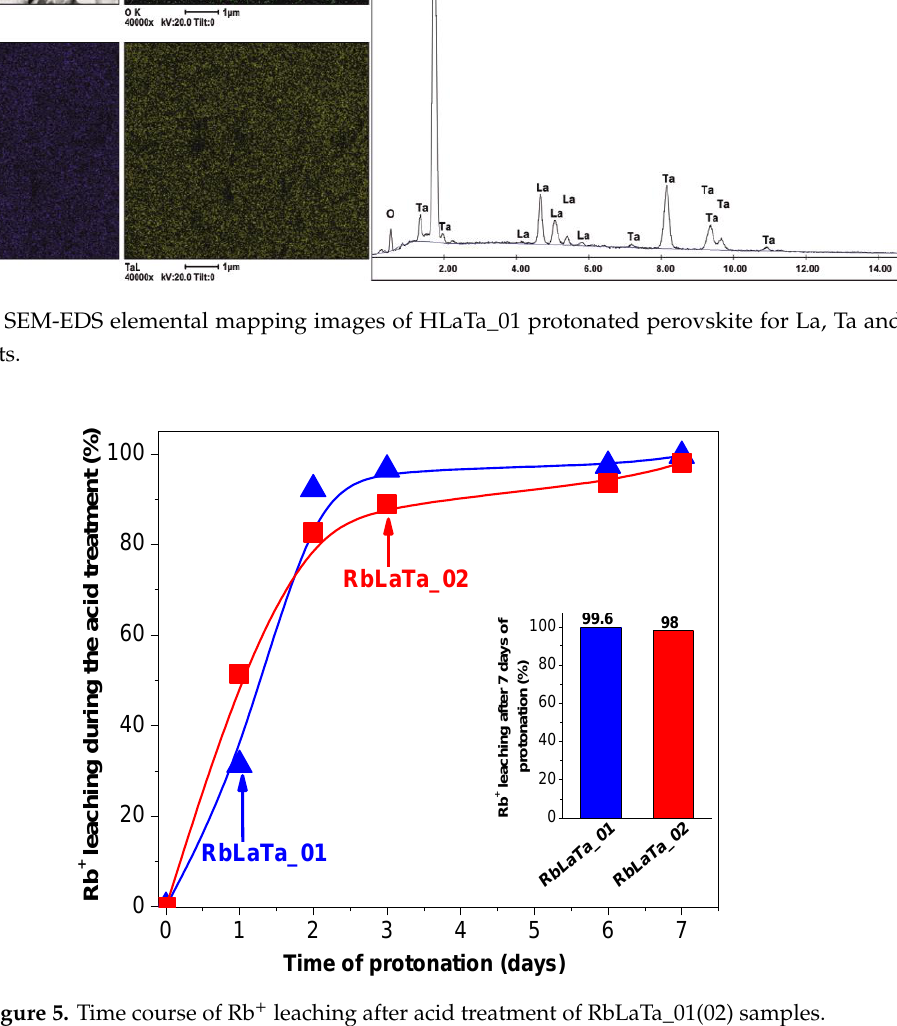
Figure 4. SEM-EDS elemental mapping images of HLaTa_01 protonated perovskite for La, Ta and O elements.